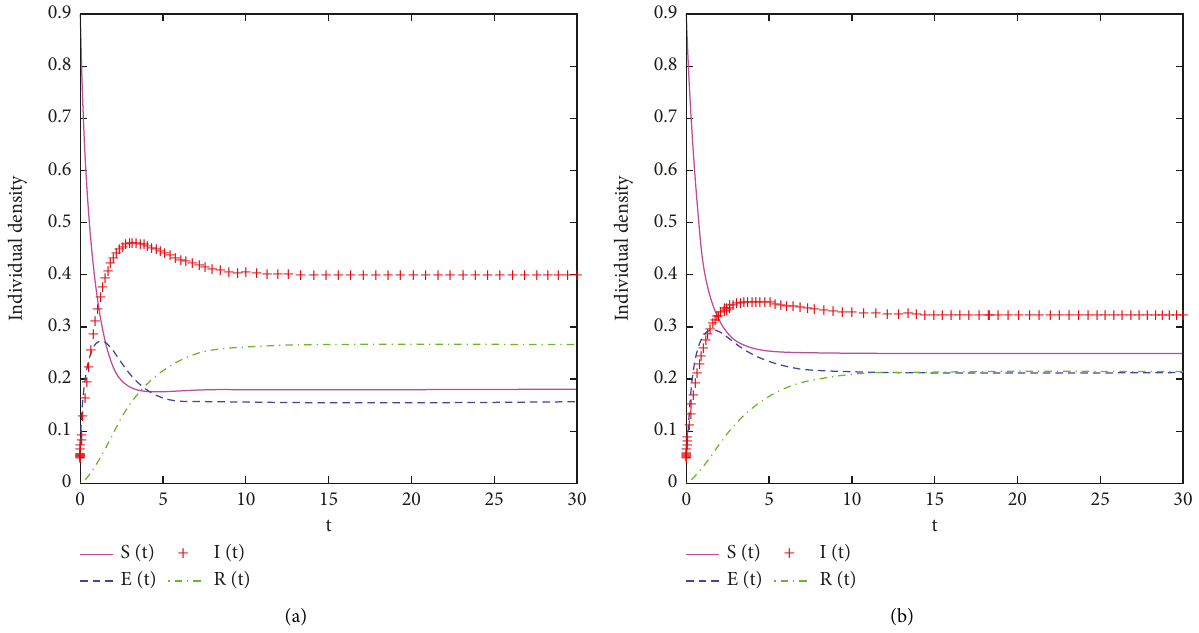
Figure 4: Simulation results of conversion rate of exposed enterprises on credit risk contagion. (a) b � 0.2. (b) b � 0.8.